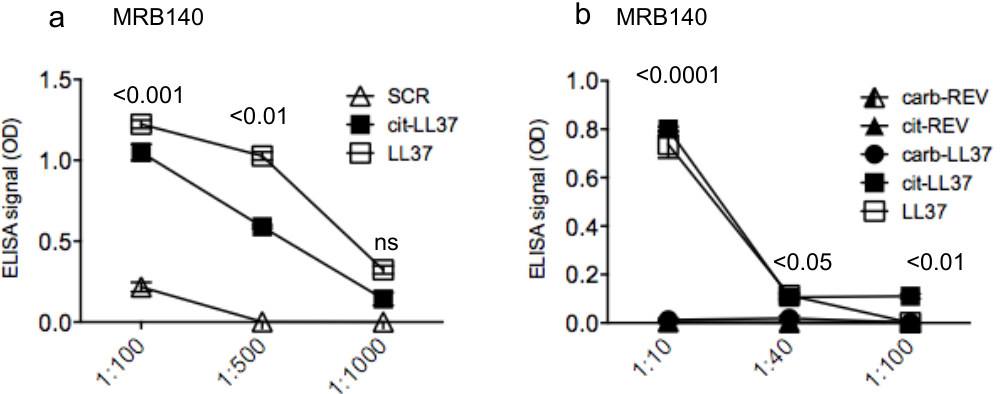
Figure 5. MRB140 is specific for both native LL37 and cit-LL37 but does not recognize carb-LL37 nor merely citrullines or homocitrullines. ( a ) MRB140 was diluted in streptavidin ELISA plates coated with biotinylated native LL37 or cit-LL37 or control SCR LL37 peptide at the indicated dilutions, and ELISA tests were performed as in Material and methods. ( b ) MRB140 does not recognize carb-LL37 nor citrulline and homocitrulline themselves. MRB140 was diluted in ELISA plates coated with native LL37 or cit-LL37 or carb-LL37 peptide or with control carb-REV or cit-REV peptides. ELISA tests were performed as in Material and Methods. In both ( a ) and ( b ) results are expressed as the mean of triplicate cultures. Standard errors of the mean are indicated. Representative results form three independent experiments. p values by Student’s paired t -test (two-tailed) refer to di ff erence between recognition of cit-LL37 as compared to all the other control peptides as